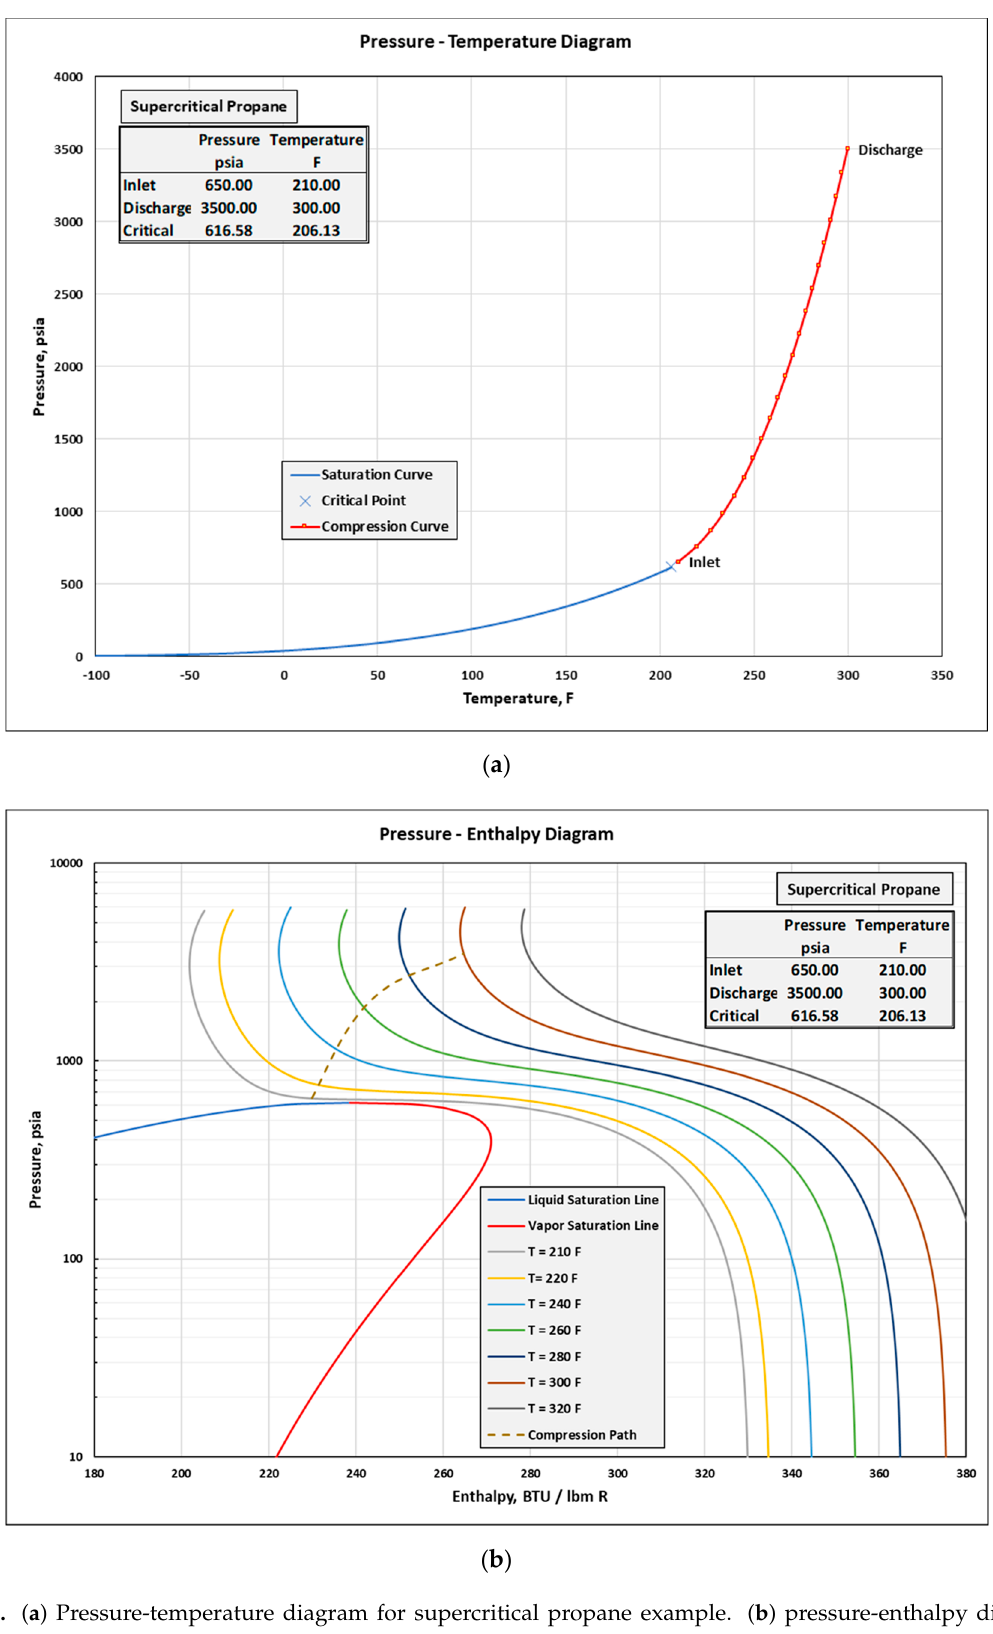
Figure A6. ( a ) Pressure-temperature diagram for supercritical propane example. ( b ) pressure-enthalpy diagram for supercritical propane example.